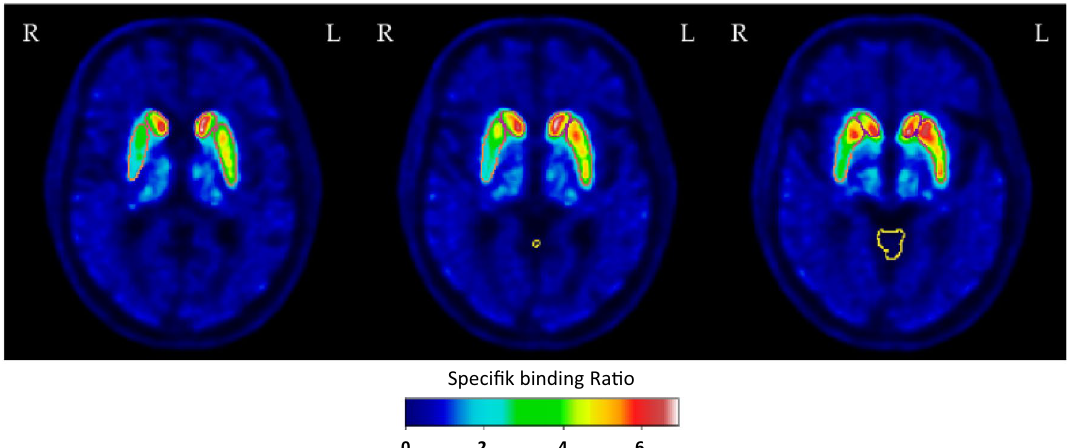
Fig. 1 Delineations of anatomical structures. Top row: Five regions of interest (ROI) representing caudate nucleus and putamen bilaterally as well as the occipital lobe were placed on a fused section of the [ 123 I]FP-CIT SPECT. Bottom: Three consecutive axial slices (superior—> inferior) of a [ 18 F] FE-PE2I PET dataset in MNI space illustrating the automated volume of interest (VOI) delineation of putamen, caudate nucleus and cerebellar